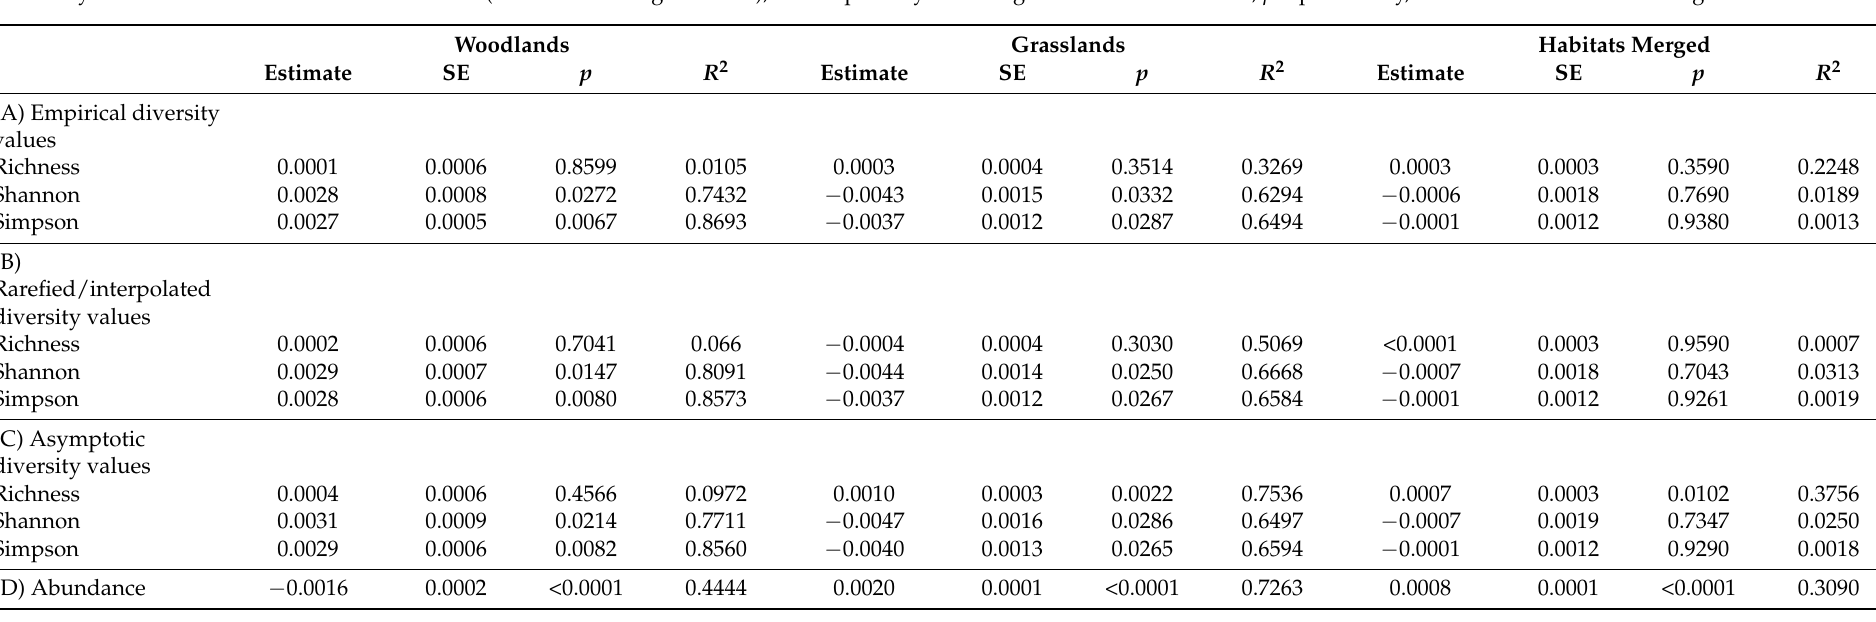
Table 3. Results of generalized linear models for the relationships between diversity ( A – C ) and abundance ( D ) of aphodiid dung beetles and altitude along an elevational gradient in central Italy. Diversity (expressed as species richness, Shannon diversity, and Simpson diversity) was calculated using empirical ( A ), rarefied/interpolated ( B ), and asymptotic ( C ) values. Analyses were conducted for the two habitats (woodlands and grasslands), both separately and merged. SE = standard error, p = probability, R 2 = Kullback–Leibler-divergence-based R 2 .